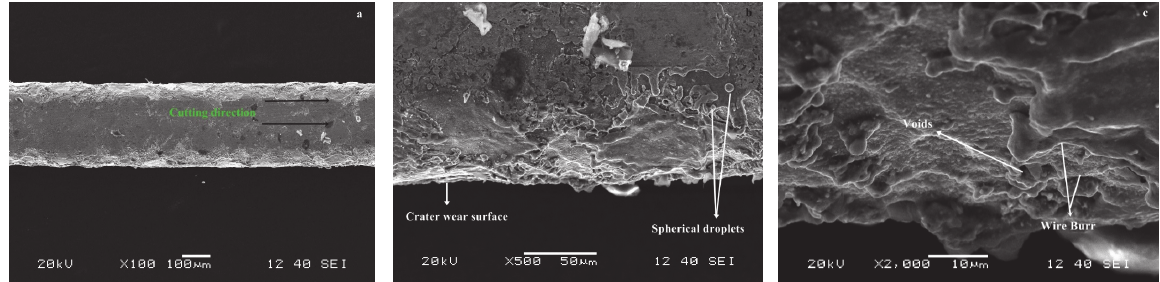
Fig. 4. Micrographs of the wire (T ON 119, T OFF 57, W T 4) after machining (a) at 100X (b) at 500X and (c) at 2000X